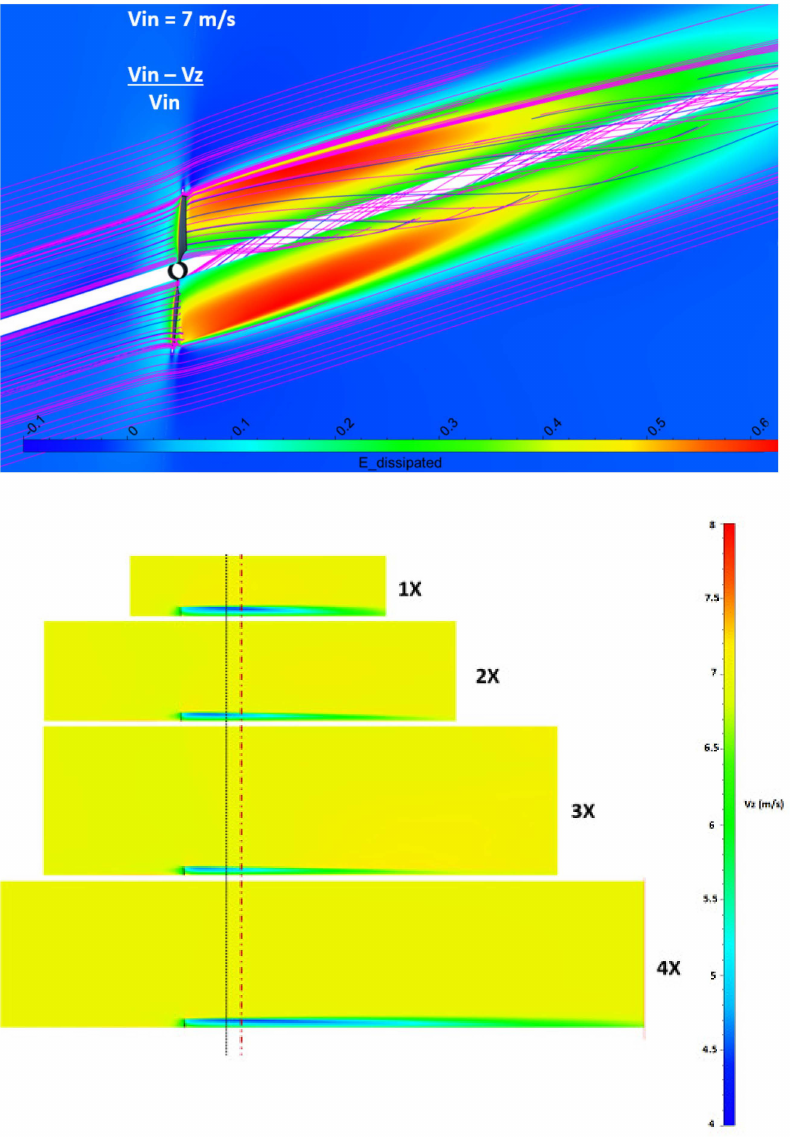
Figure 28. Perspective view of velocity deficit downstream of the wind turbine rotor showing the streamlines. Different domains showing velocity decrease downstream of